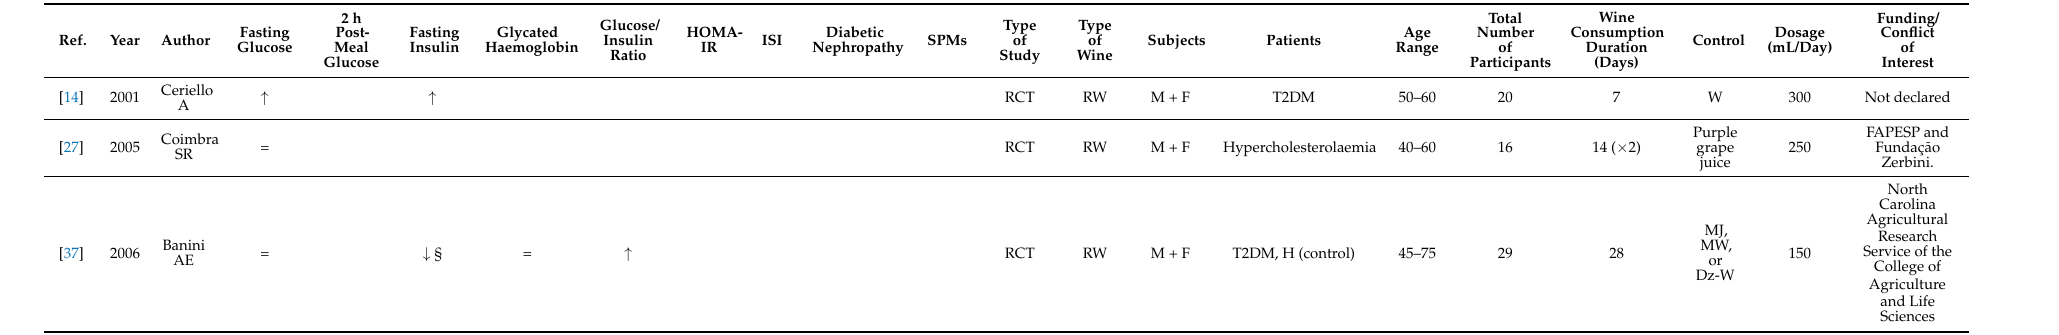
Table 9. Effects of red wine on glycaemic control in individuals with type 2